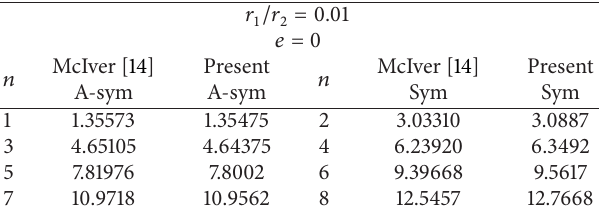
Table 1: Validation of the natural sloshing